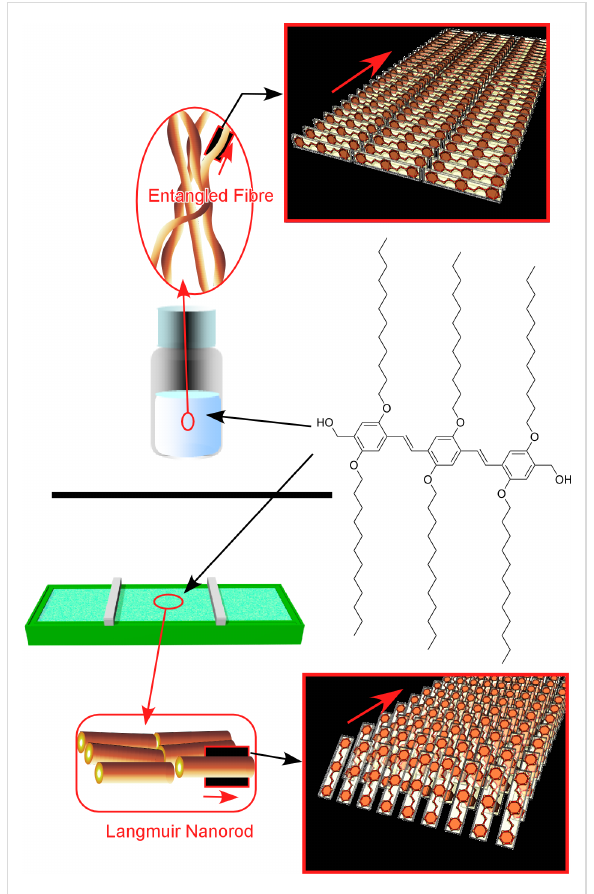
Figure 7: Difference of one-dimensional assemblies of an oligo( p - phenylenevinylene) derivative formed in different media: (top) entan- gled fibre structures formed in toluene solution and drop-cast on a solid surface; (bottom) aligned rods formed at the air–water interface. Adapted from [75], copyright 2019 The